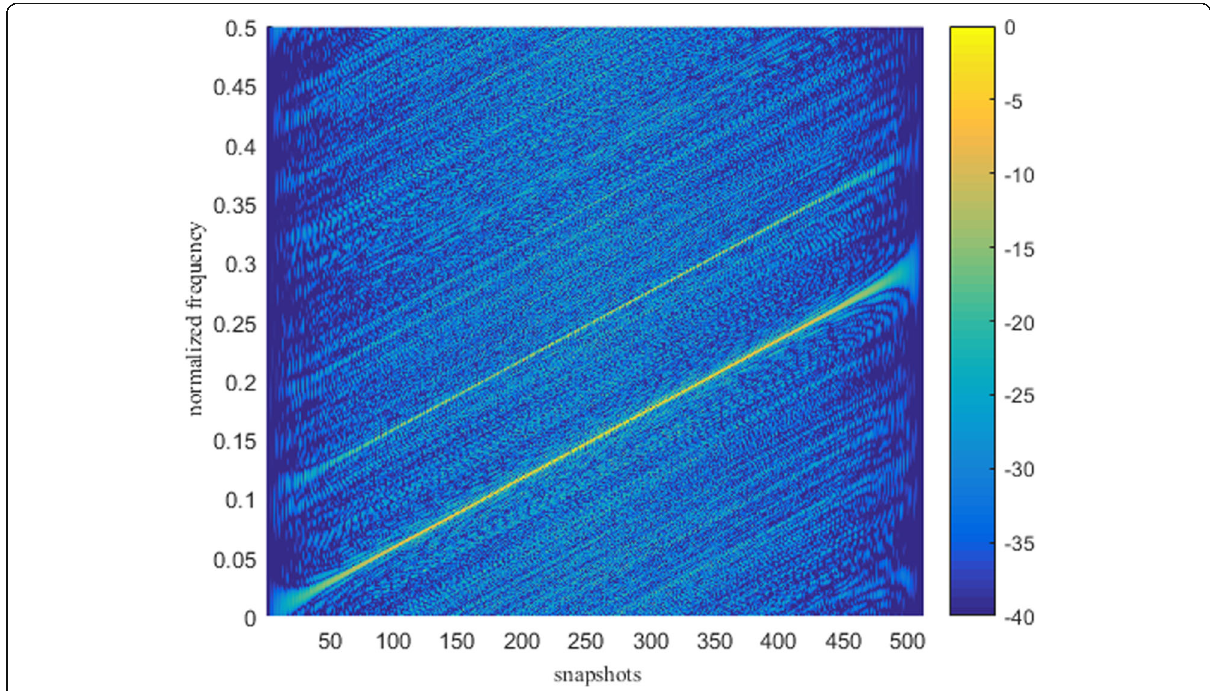
Fig. 1 T-F spectrum of two LFM